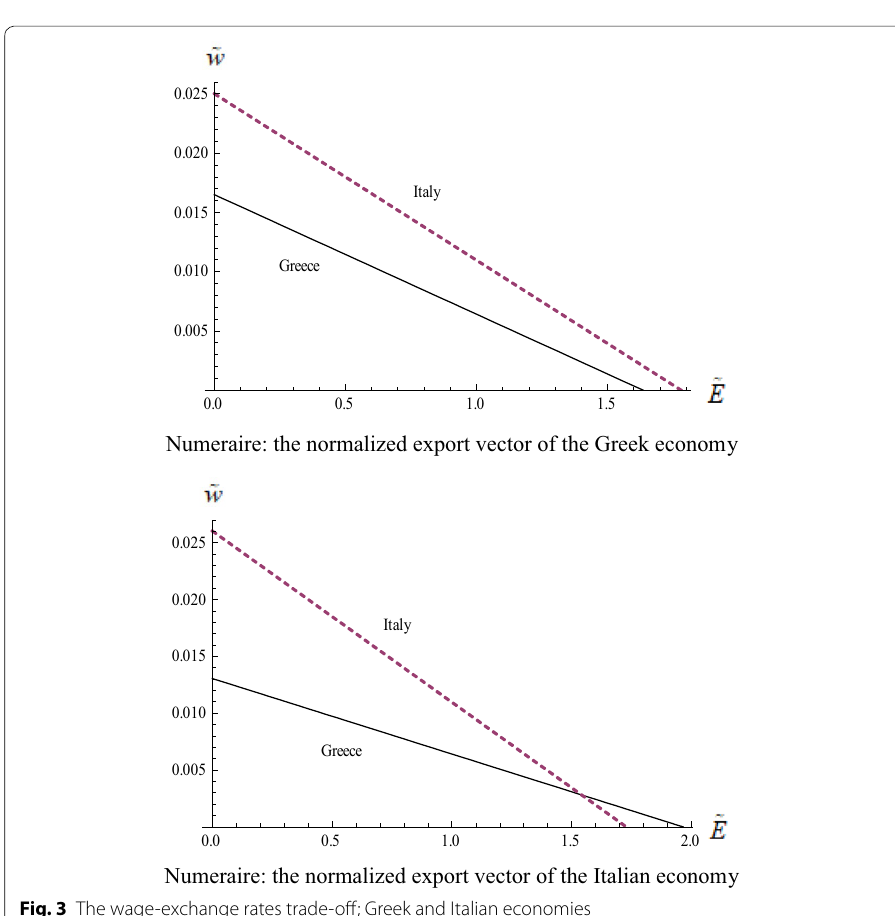
Fig. 3 The wage-exchange rates trade-off; Greek and Italian